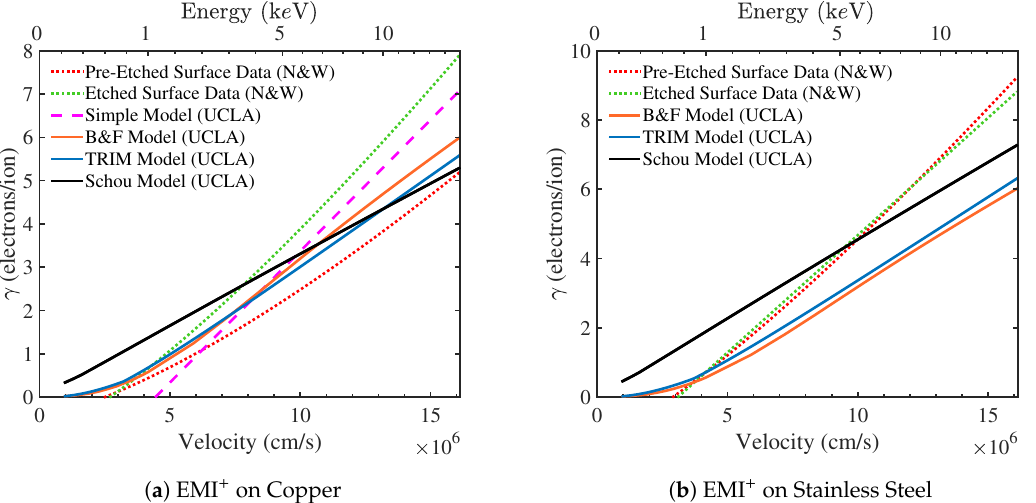
Figure 8. Electron yield for EMI–Im cations (EMI + ) as a function of impact velocity, corresponding to impact energies of 0.05–15 keV. References for the original models are as follows: Simple model [51], B&F and TRIM models [38], and Schou model [54]. Data come from fit models derived empirically by Nguyen and Wien (N&W) [63].